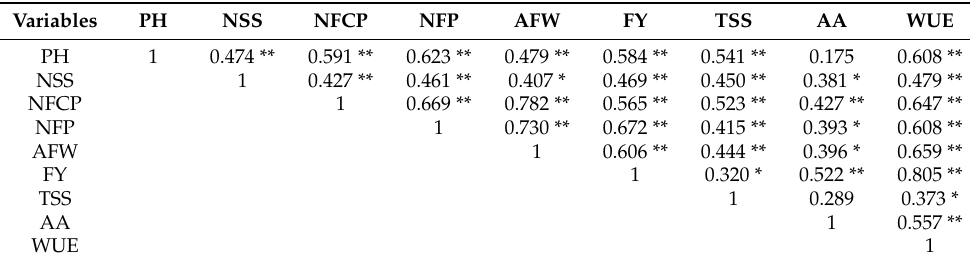
Table 10. Simple correlation coefficient among growth, yield, and quality